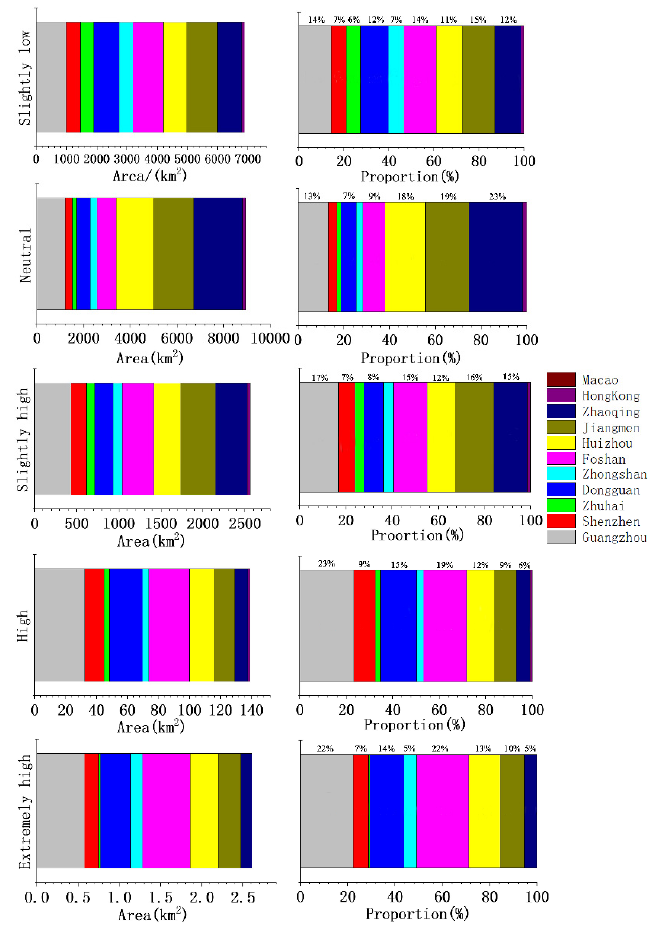
Figure 5. Statistical diagram of the classification of land-use-change frequency.